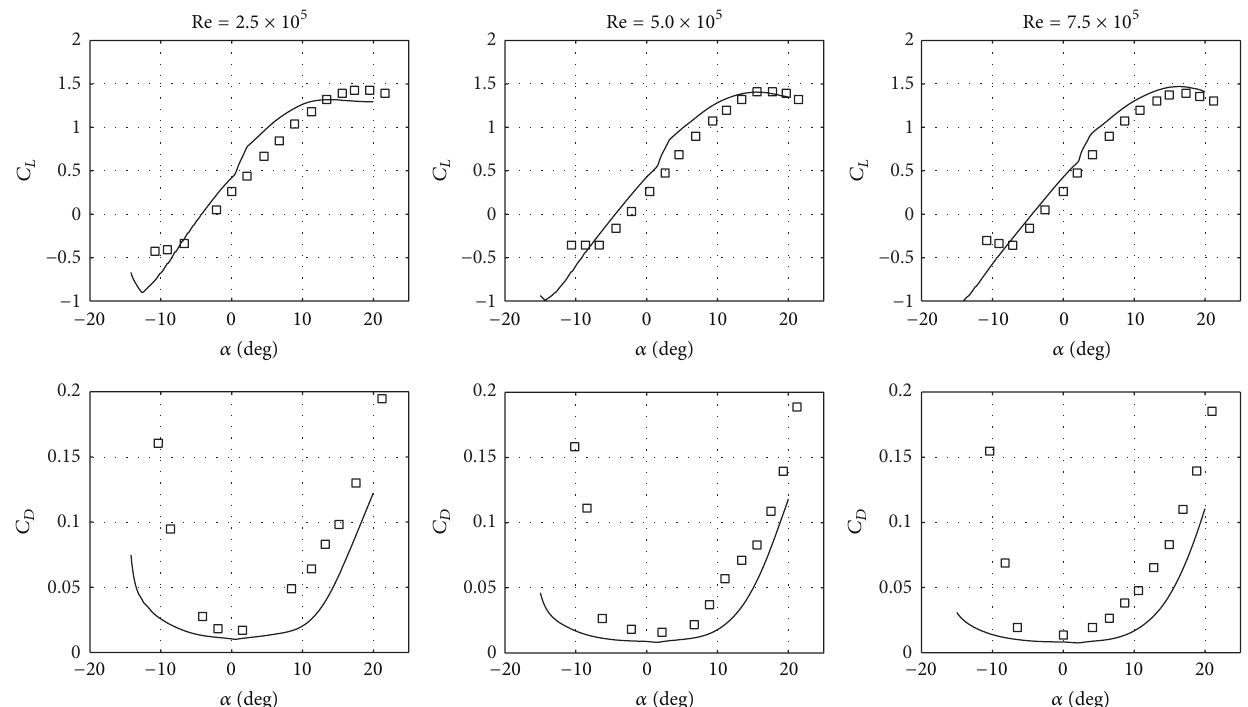
Figure 4: Coefficients of prestall lift and prestall drag as a function of angle of attack measured by Ostowari and Naik [5] (square marker) and predicted by XFOIL (solid line) for a NACA 4415 blade of infinite aspect ratio (AR) at Re = 2.5 × 10 5 , 5.0 × 10 5 , and 7.5 × 10 5 .